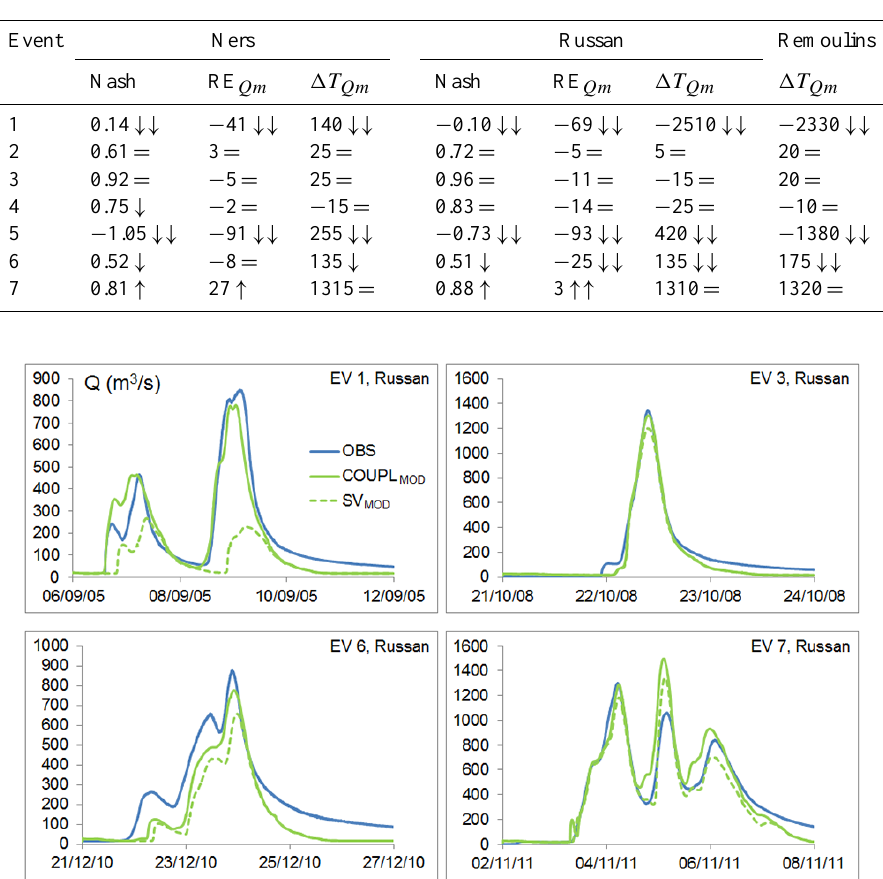
Table 8. SV MOD option results. Performance indexes at the Ners, Russan and Remoulins stations. The symbols on the right of the indexes characterise the gaps compared with the COUPL MOD option. ↓↓ : deterioration of more than 50%; ↓ : deterioration of between 5 and 50%; ↑ : improvement of between 5 and 50%; ↑↑ : improvement of more than 50%; = : close values, within ± 5%. Symbol also attributed to